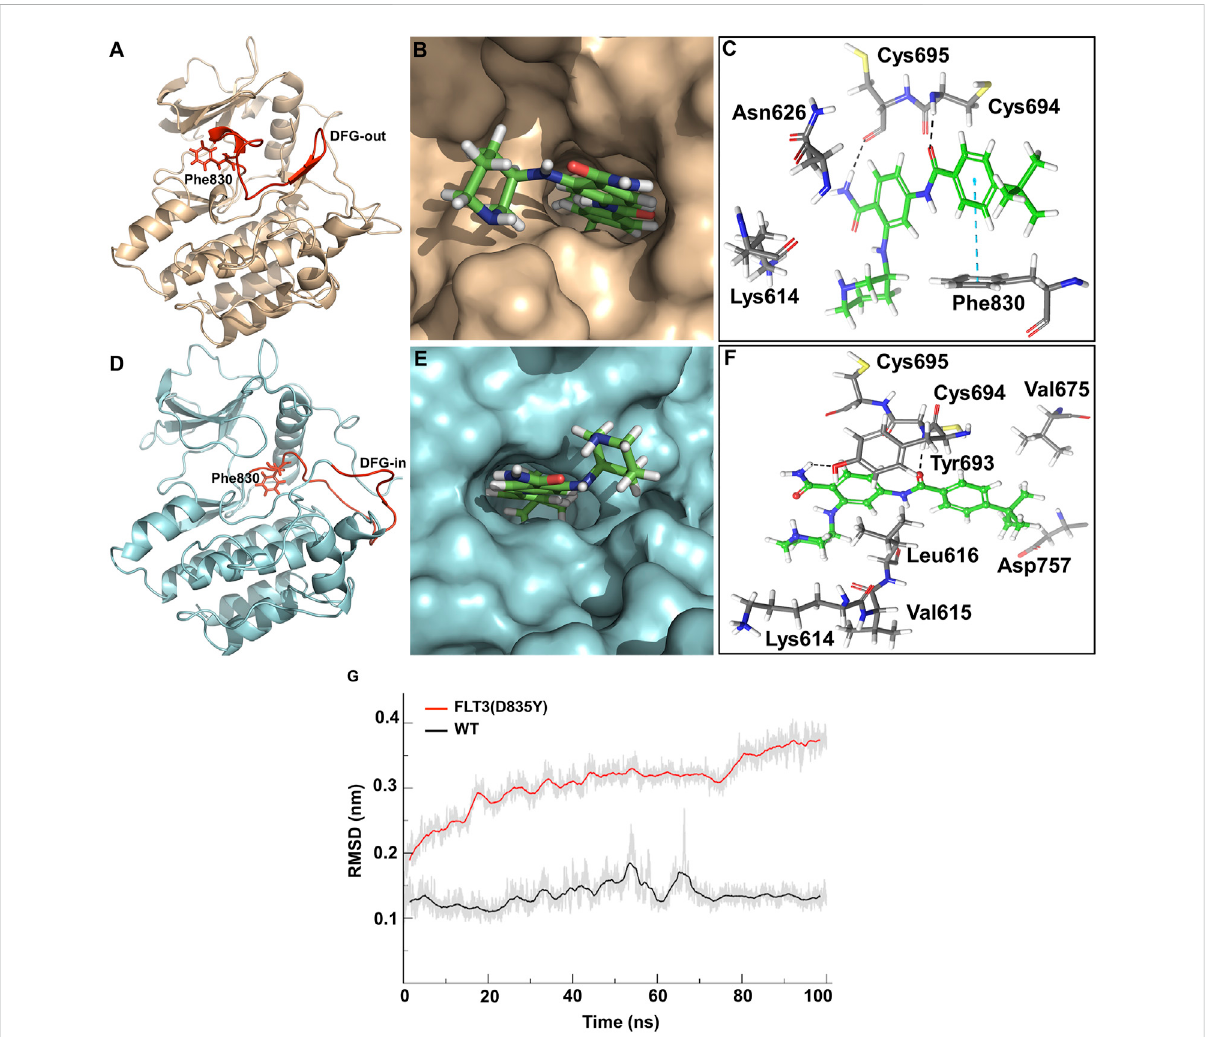
FIGURE 4 Bindinganalysis ofPCW-A1001. (A) DFG-outconformationofFLT-3wildtype (B) BindingmodeofPCW-A1001withFLT-3wildtype (C) Crucial interactionsobservedintheFLT-3wild-type(sticks). (D) DFG-inconformationofFLT-3(D835Y)mutant, (E) BindingmodeofPCW-A1001withFLT-3 (D835Y), (F) Crucial interactions observed in the FLT-3 (D835Y) (sticks). Hydrogen bond interactions are represented in black dashed lines and pi-pi interactions in the blue dashed lines. (G) RMSD (C α ) plot of FLT-3 wild type and D835Y mutant.